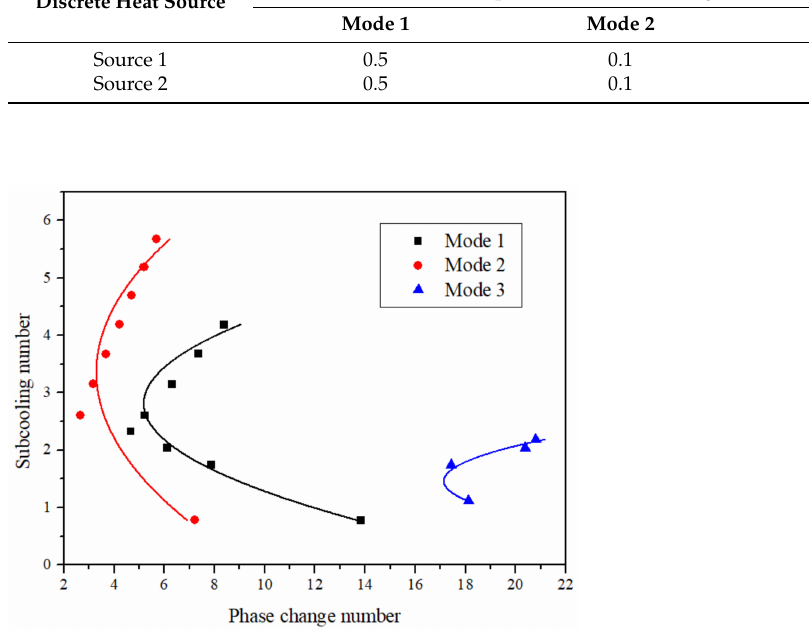
Figure 12. Stability boundary of discrete heat source with different numerical